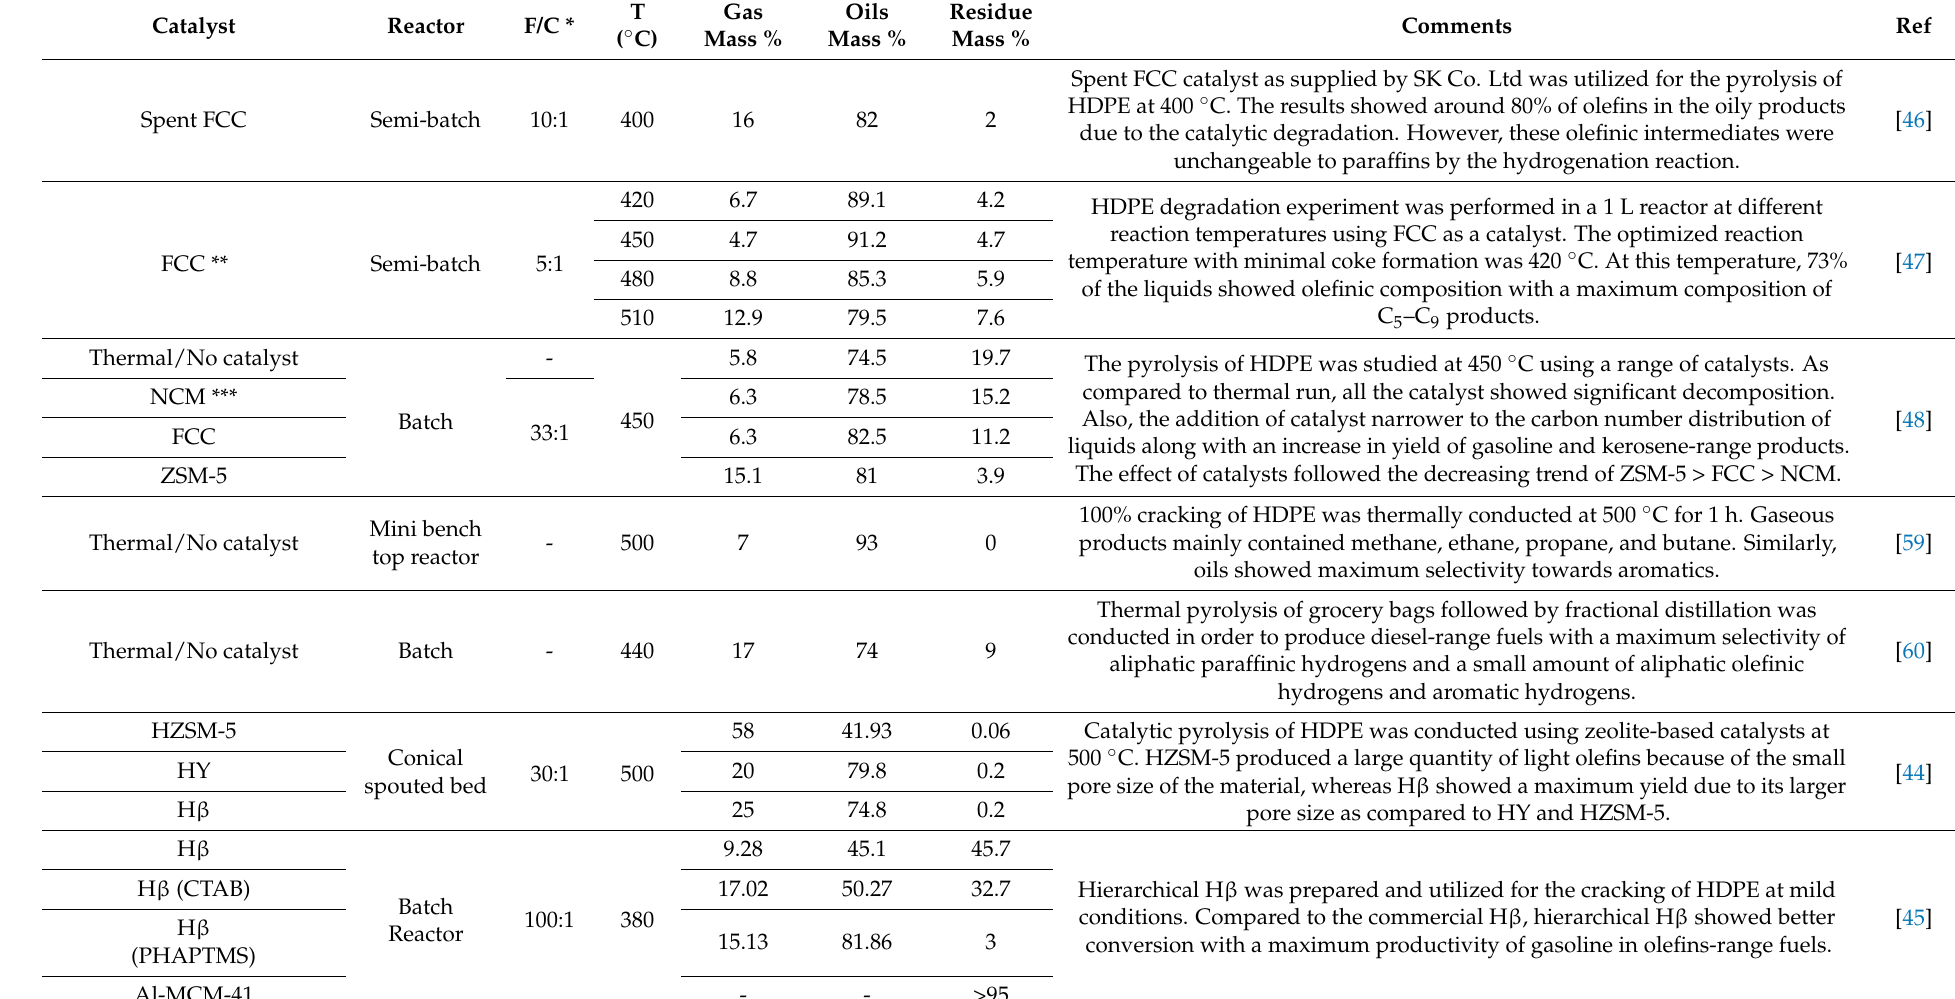
Table 8. Summary of HDPE pyrolysis